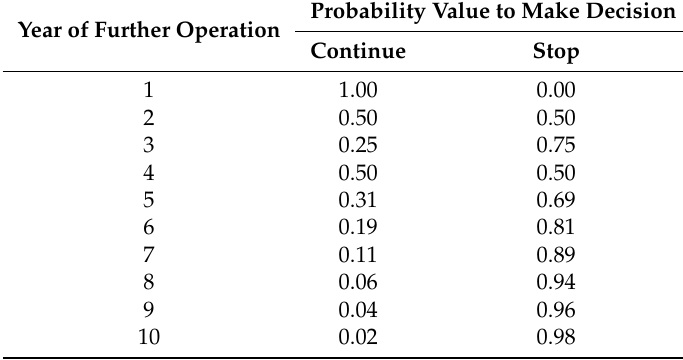
Table 5. Probability of the continuation or abandonment for all analyzed PV power plants in the next 10 years after EEG levy expiration for O&M costs of 33 e /kW per annum and abandonment value of 5% of the new investment